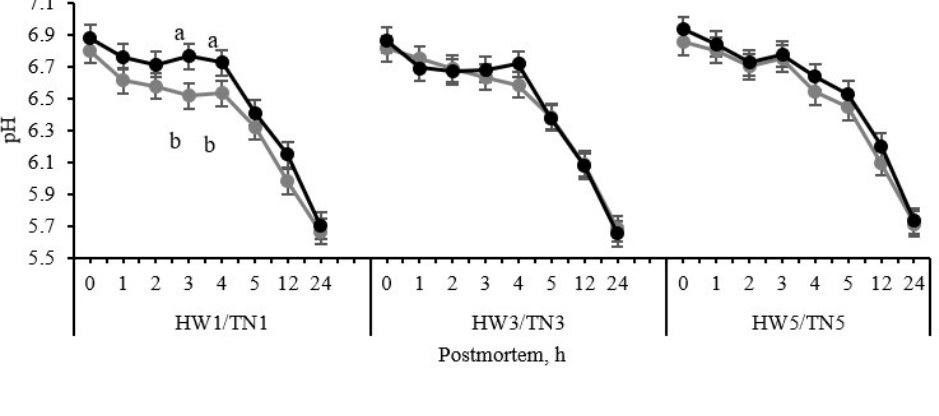
Figure 3. The effect of temperature (thermoneutral, TN vs. heatwaves, HW) and heat exposure duration (1 vs. 3 vs. 5 days) on pH drop of the longissimus thoracis et lumborum muscle at 5 min, 1 h, 2 h, 3 h, 4 h, 5 h, 12 h, 24 h postmortem: values are mean ± SED; a and b indicate levels that are significantly different at 5% level of LSD in the same timepoint; HW/TN1–5 = 1 to 5 days HW/TN groups ( n = 12 per group); pH: temp. p = 0.12; day p = 0.20; temp. × day p = 0.31.